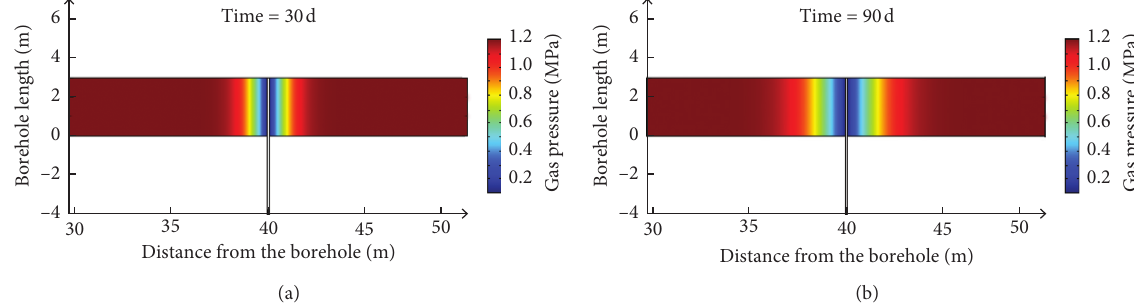
Figure 8: Cloud map of gas pressure when extracting gas from the borehole with 94mm diameter. (a) Time � 30d. (b) Time � 90d.